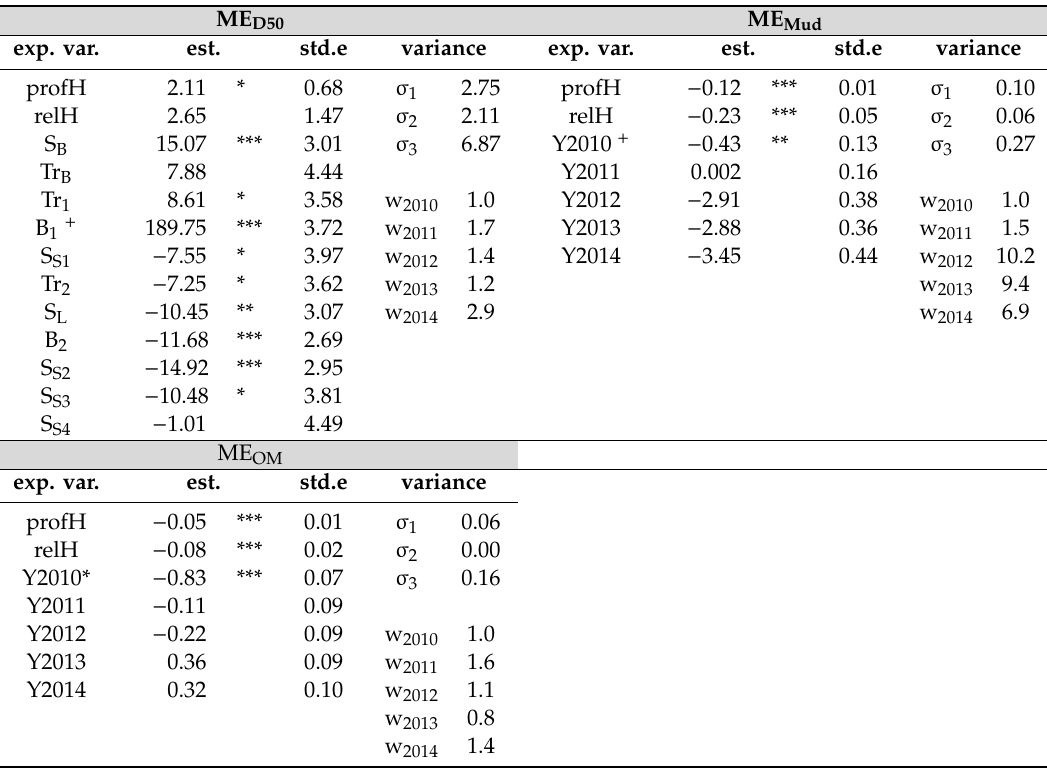
Table 2. Model estimates for selected explanatory variables (fixed e ff ects) and variance (random e ff ects) for the ME-models predicting median grain size (ME D50 ), percentage mud (ME Mud ), and organic matter (ME OM ). ME D50 ME Mud exp. var. est. std.e variance exp. var. est. std.e variance profH 2.11